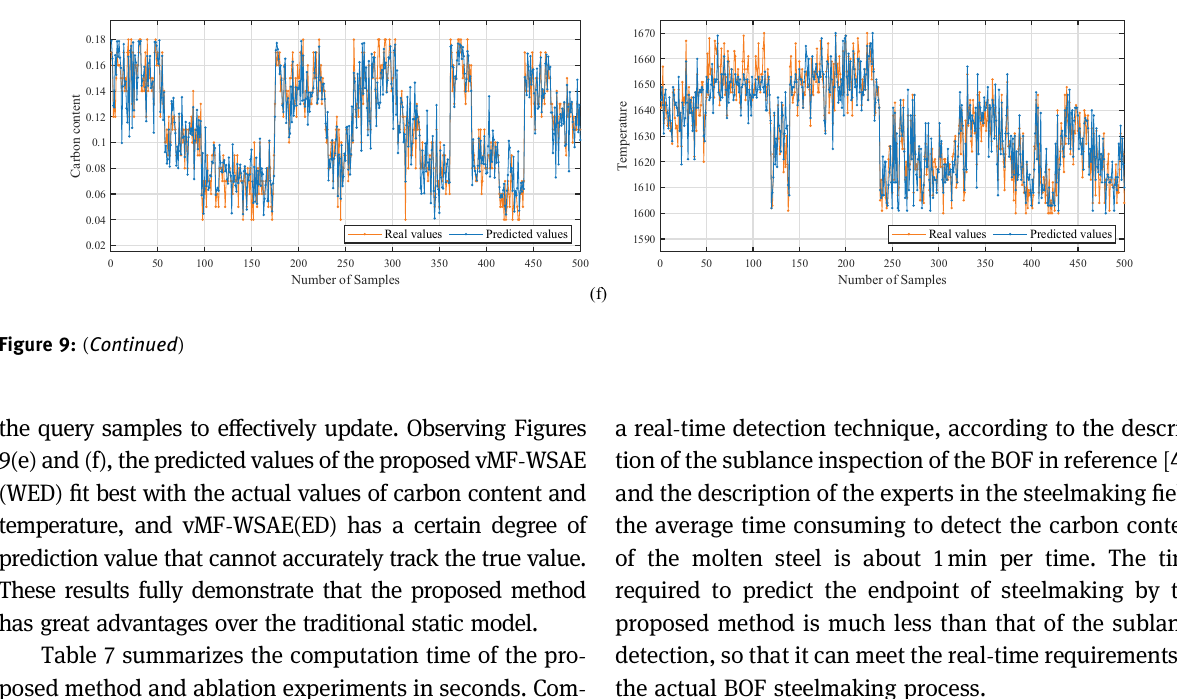
Table 7: Performance comparison of the proposed method and ablation experiments in terms of computation time Datasets